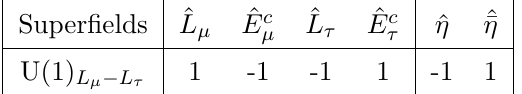
Table 1. L µ − L τ charge assignments for the chiral superfields that are not singlets under the additional